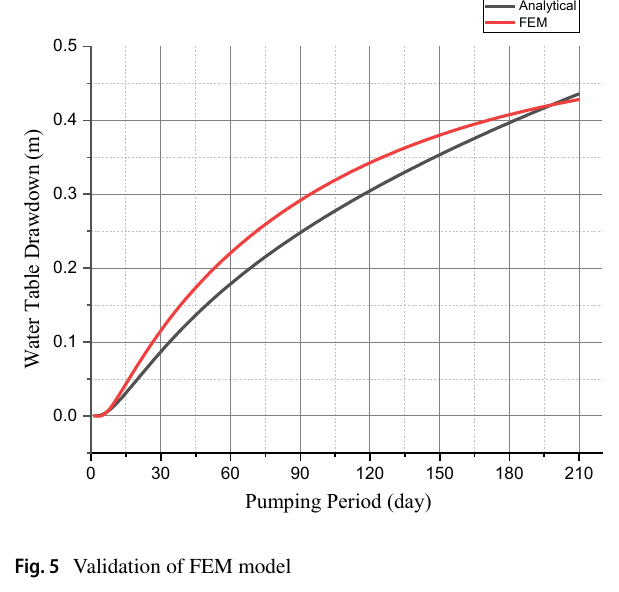
Fig. 5 Validation of FEM model